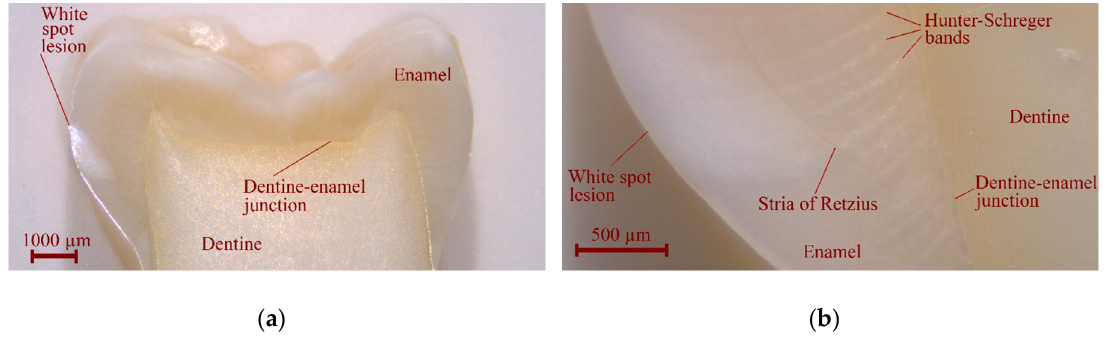
Figure 1. Optical microscopy of the sample after final polishing: ( a ) the crown overview; ( b ) the white spot lesion (WSL) area.